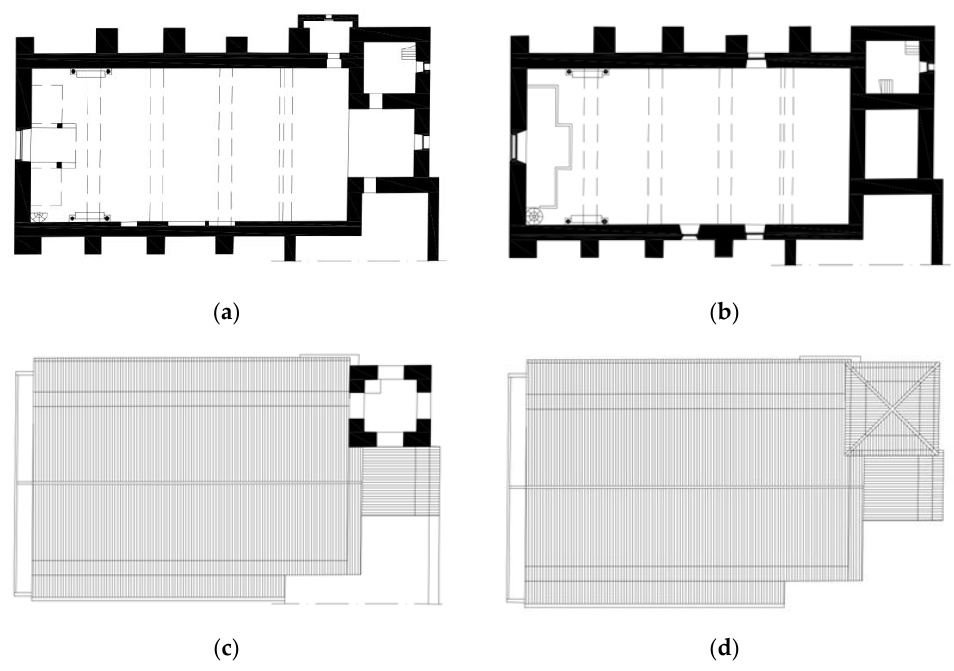
Figure 6. Geometrical survey of the church [47]. ( a ) Entrance-level plan of St. Salvatore church; ( b ) choir-level plan of St. Salvatore church; ( c ) plan at the bell tower opening level; ( d ) roof plan.